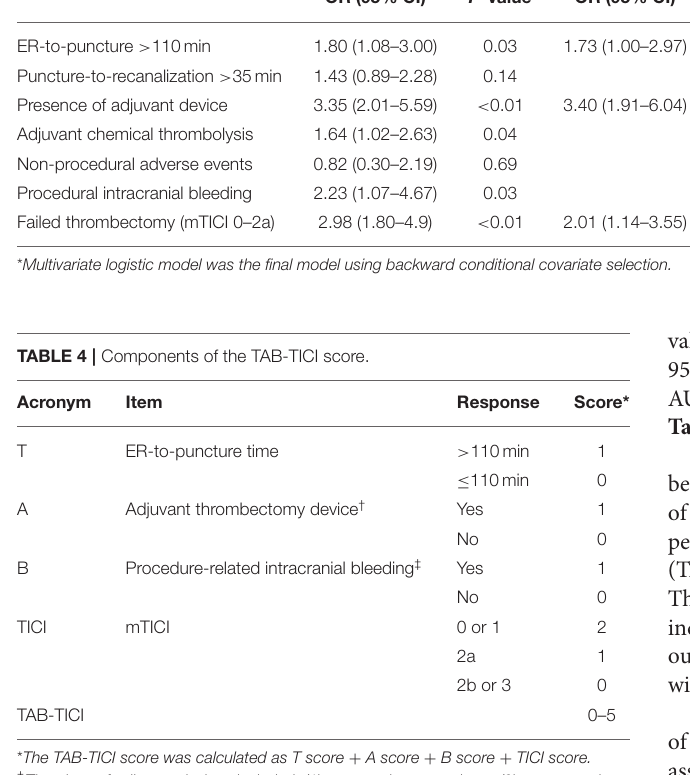
TABLE 3 | Selection of items from the major categories related to early neurological aggravation and favorable outcomes.